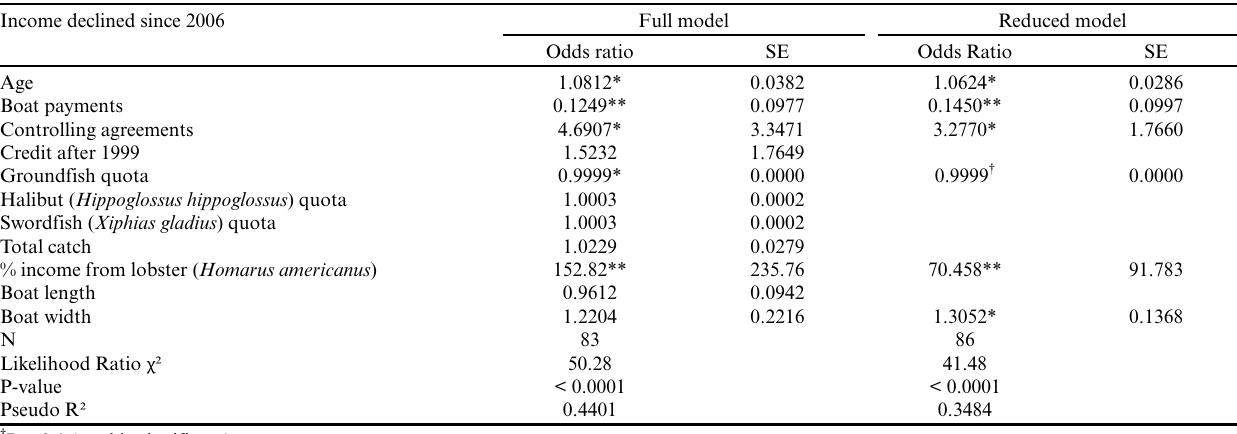
Table 3 . Binomial logit model of factors explaining whether a captain’s income has declined since 2006. Income declined since